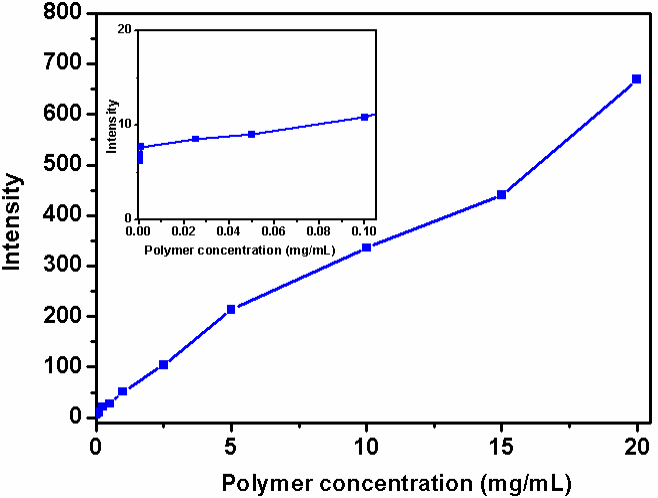
Figure 3. Intensity of the fluorescence emission of Nile red at 620 nm ( λ ex = 550 nm; slit widths: E x. 5 nm, E m. 5 nm) as a function of concentration of β -CD-(PLA- b -PDMAEMA- b -PEtOxMA) 21 as well as an expanded view of the low concentration range (inset).